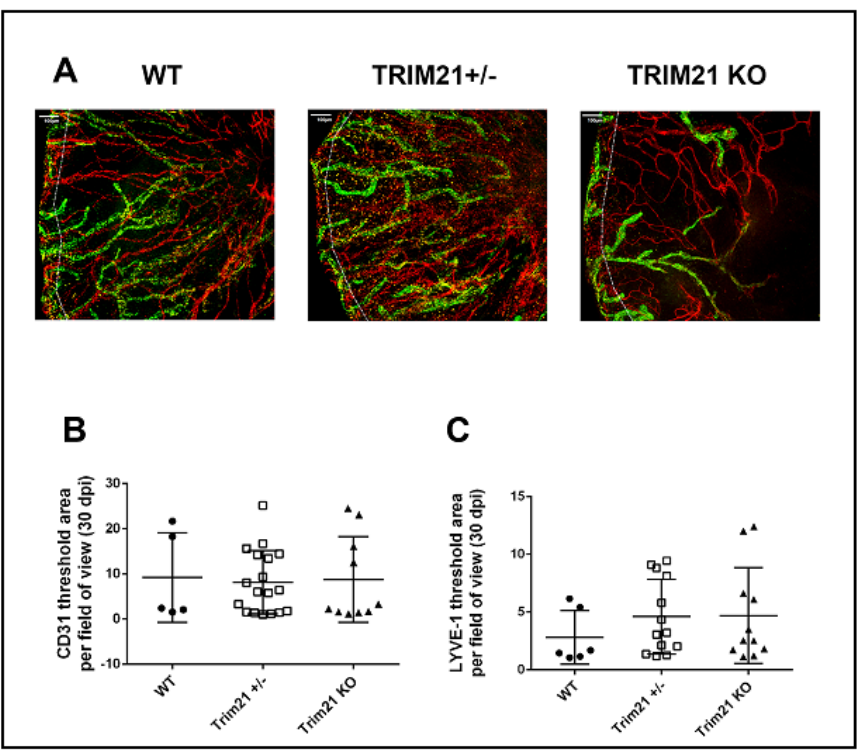
Figure 4. Corneal neovascularization is similar between WT, TRIM21+/ − and TRIM21 KO mice in response to HSV-1 infection. Male and female C57BL/6 (WT), TRIM21+/ − , and TRIM21 KO mice (n = 5–18/group) were infected with HSV-1 (10 3 PFU/cornea). At 30 days post infection, the mice were exsanguinated, and the corneas were removed, processed, and stained for neovascularization measuring of lymphatic (green) and blood (red) vessel genesis into the central cornea, captured by confocal microscopy. ( A ) Representative images of corneas from WT, TRIM21+/ − , and TRIM21 KO infected mice at day 30 pi. Dotted line depicts the limbus margins. Summary of the area occupied by ( B ) CD31+ blood and ( C ) LYVE-1+ lymphatic vessels for each group of mice. Horizontal bars represent the mean + SEM. The white scale bar = 100 µm.